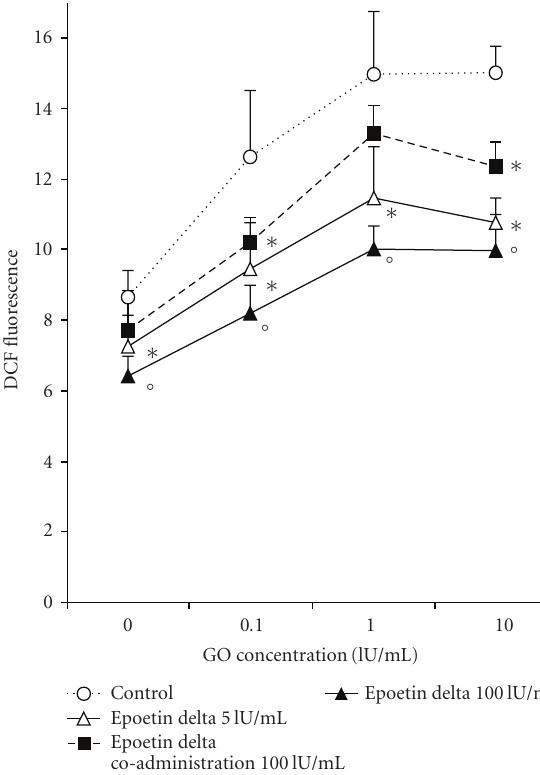
Figure 1: Induction of oxidative stress in confluent hTECs by incubation with GO (0 to 100 IU/mL) during 0 to 240 minutes. By measuring DCF fluorescence, a concentration-dependent accumu- lation of ROS was observed during the time.